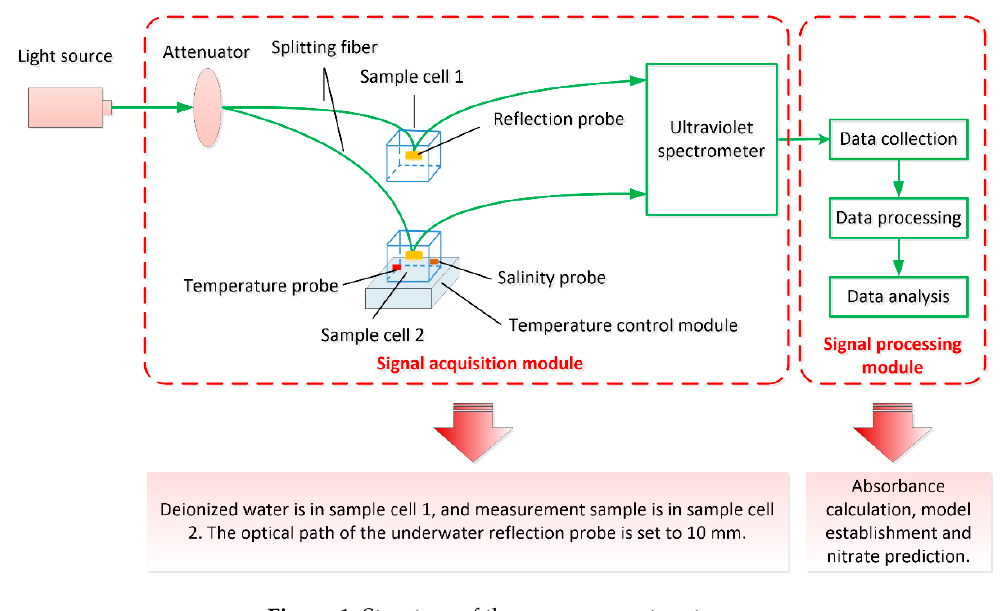
Figure 1. Structure of the measurement system. Table 1. Specifications of the